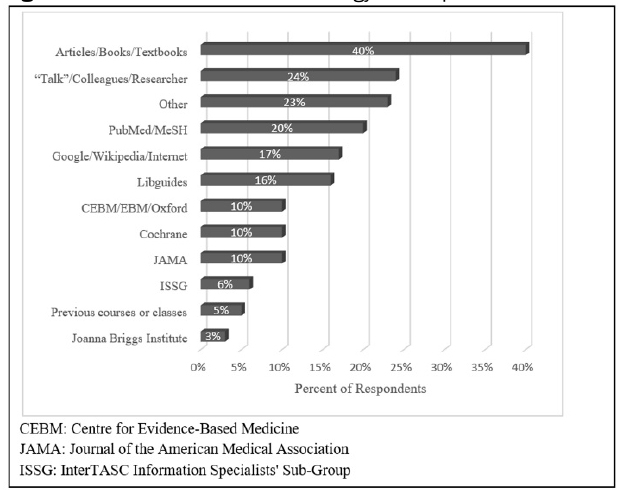
Figure 4 Resources for search strategy